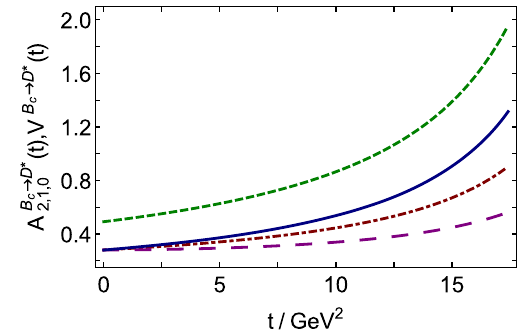
Fig. 4 SCI predictions for B + c → D ∗ 0 transition form factors: A 2 ( t ) – dot-dashed red curve; A 1 ( t ) – long-dashed purple; A 0 ( t ) – solid blue; V ( t ) – dashed